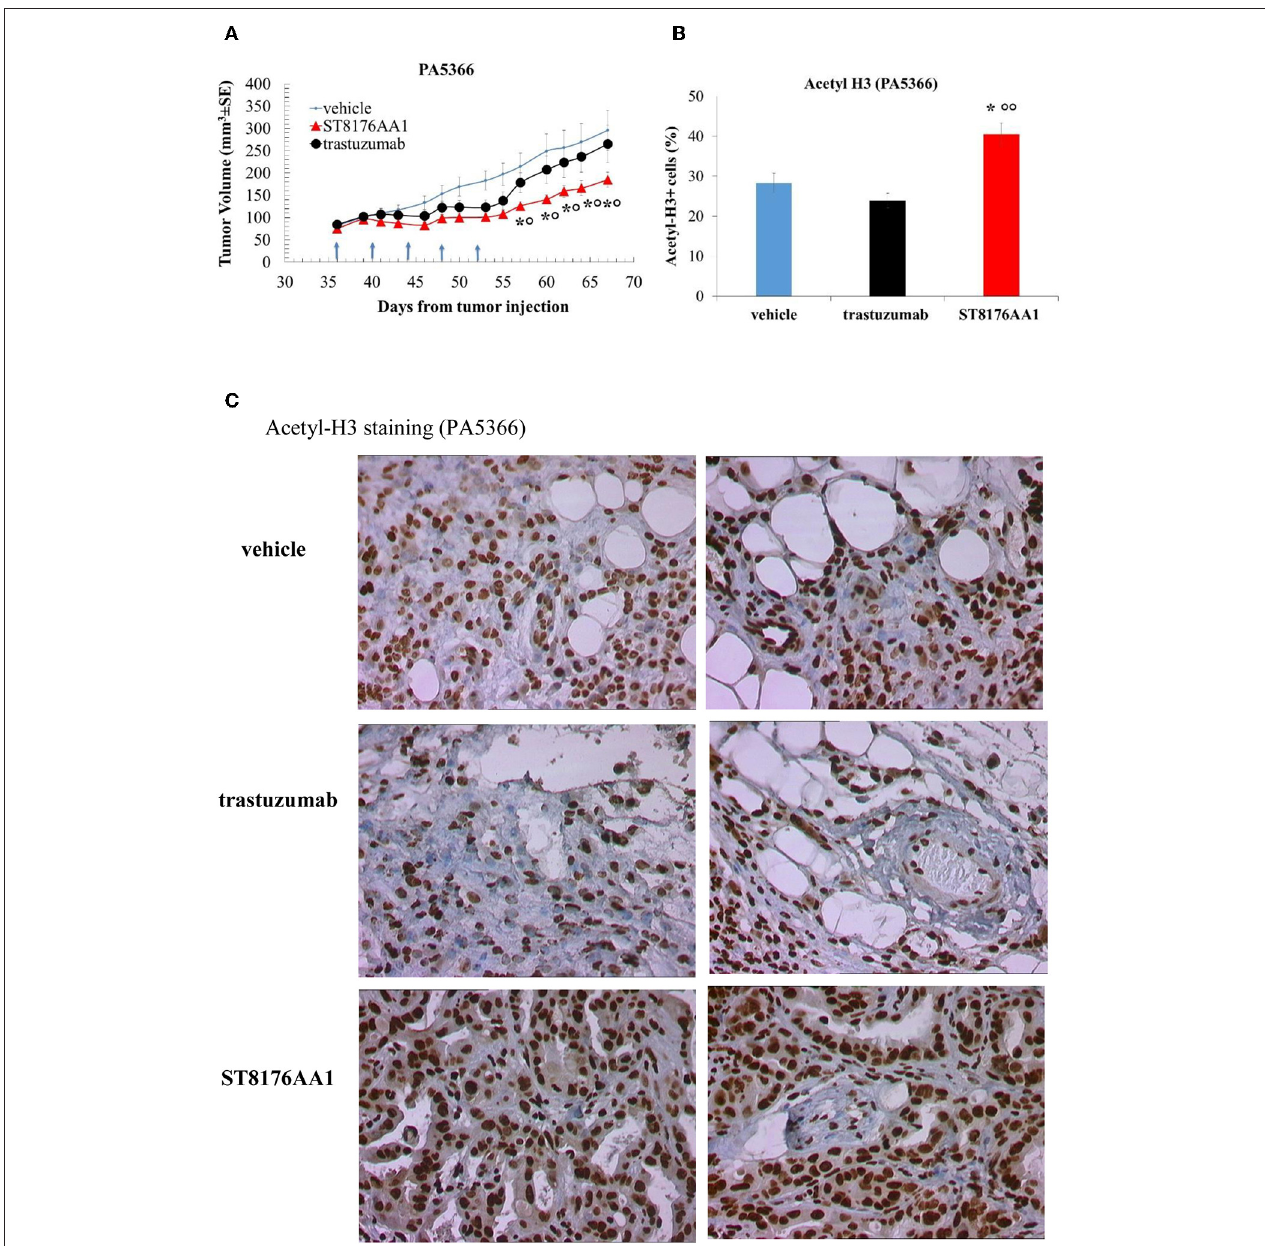
FIGURE 11 | Anti-tumor efficacy of ST8176AA1 in PDX pancreatic carcinoma model of PA5366. (A) NODSCID mice (10/group) bearing patient-derived pancreatic carcinomas PA5366 were treated i.p. with ST8176AA1 or trastuzumab (5 doses of 15 mg/kg once every 4 days, starting 36 days after tumor transplantation as indicated by arrows in the graph). One group received vehicle (PBS) with the same schedule. Tumor growth was monitored using a Vernier caliper. Data are expressed as mean ± SE. Statistical analysis by Mann-Whitney’s test. * P < 0.05 vs. vehicle and ◦ P < 0.05 vs. trastuzumab. (B) Tumor masses at the end of the study were analyzed by immunohistochemistry. Cells positive for acetyl-histone H3 from PA5366 were counted by two independent observers in five randomly selected fields. Data in the graph are expressed as the mean of positive cells × 100/total cells ± SE or as score with negative staining, score 0; 1-20% positive cells, score 1 + ; 21-50% positive cells, score 2 + > 50% positive cells, score 3 + . Statistical analysis by Mann-Whitney’s test. * P < 0.05 vs. vehicle-treated group; ◦◦ P < 0.01 vs. trastuzumab. (C) Representative immunohistochemistry pictures for acetyl-histone H3 are shown. Images captured using 40 × magnification. Scale bar: 500 µ m.